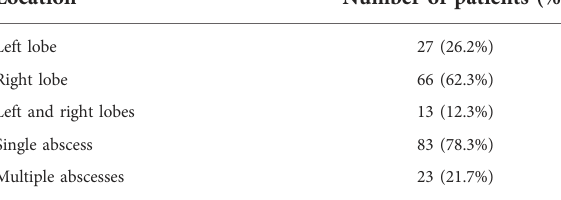
TABLE 4 Location and number of PLA.